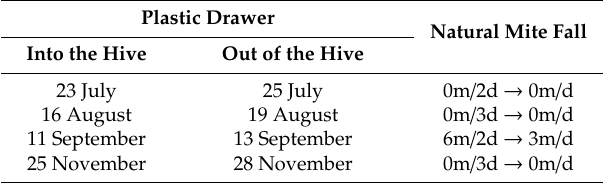
Table 2. Varroa screening plan in 2019 by debris examination for the surviving colony 1. Plastic Drawer Natural Mite Fall Into the Hive Out of the